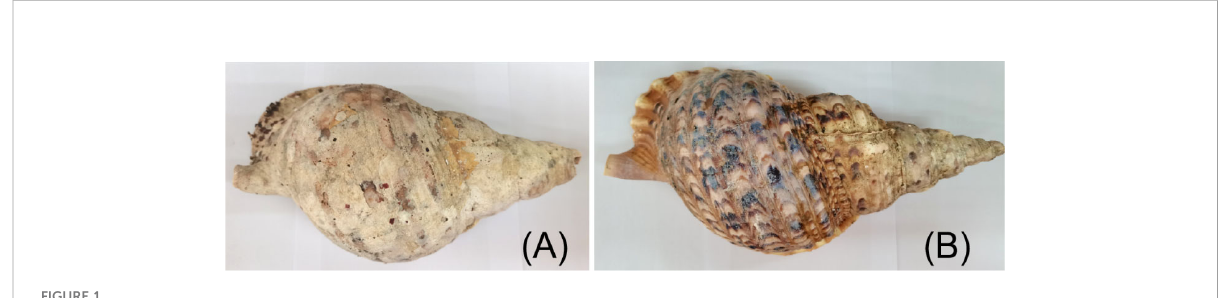
FIGURE 1 C tritonis with white shell (A) , C tritonis with fl ower shell (B)